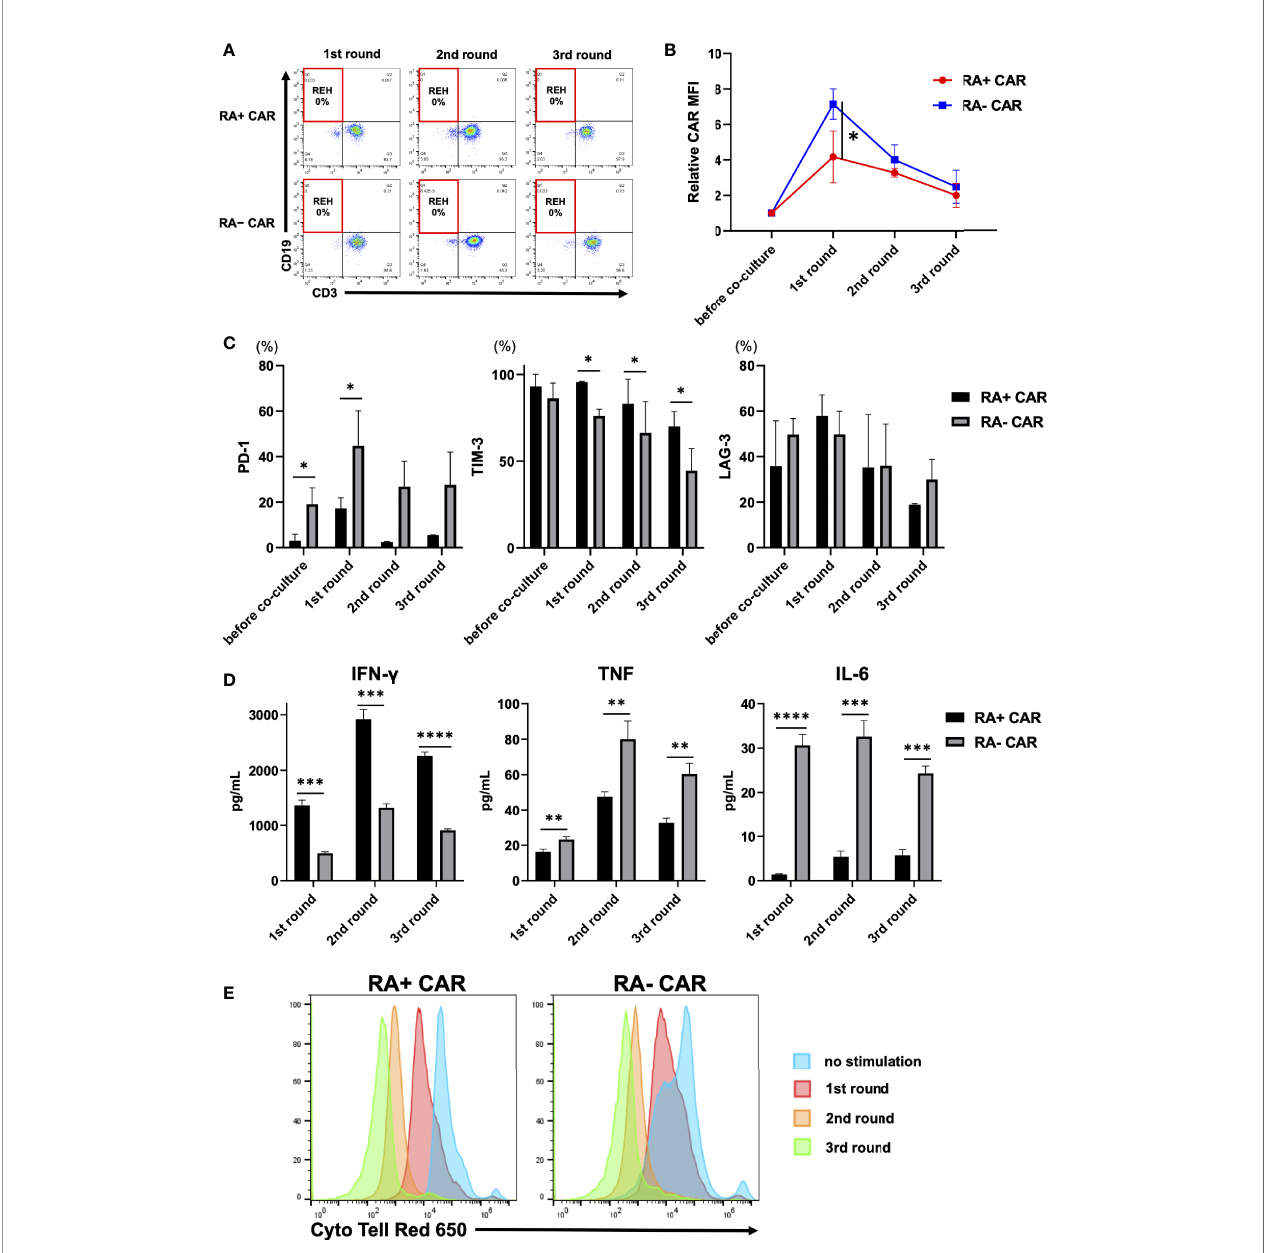
FIGURE 2 | Analysis of chimeric antigen receptor (CAR) function by in-vitro serial tumor challenge assay. (A) The expression of CAR-T and REH cells during sequential co-culture. Representative dot plots are shown. (B) Relative CAR mean fl uorescence intensity (MFI) (MFI = 1, before co-culture) of CAR-T cells during sequential co-culture (n = 3). CAR MFI of CAR-T cells were calculated after gating on the CAR positive population. (C) The expression of PD-1, TIM-3, and LAG-3 on CAR-T cells during sequential co-culture (n = 3). (D) The level of cytokines in the co-culture supernatant containing CAR-T cells with REH cells after sequential co- culture (n = 3). (E) Cell division of CAR-T cells upon repeated REH cells stimulations or no stimulation. All data are presented as means ± standard deviation. *P < 0.05, ***P < 0.01, ***P < 0.001, ****P < 0.0001. PD-1, programmed cell death protein-1; TIM-3, T cell immunoglobulin